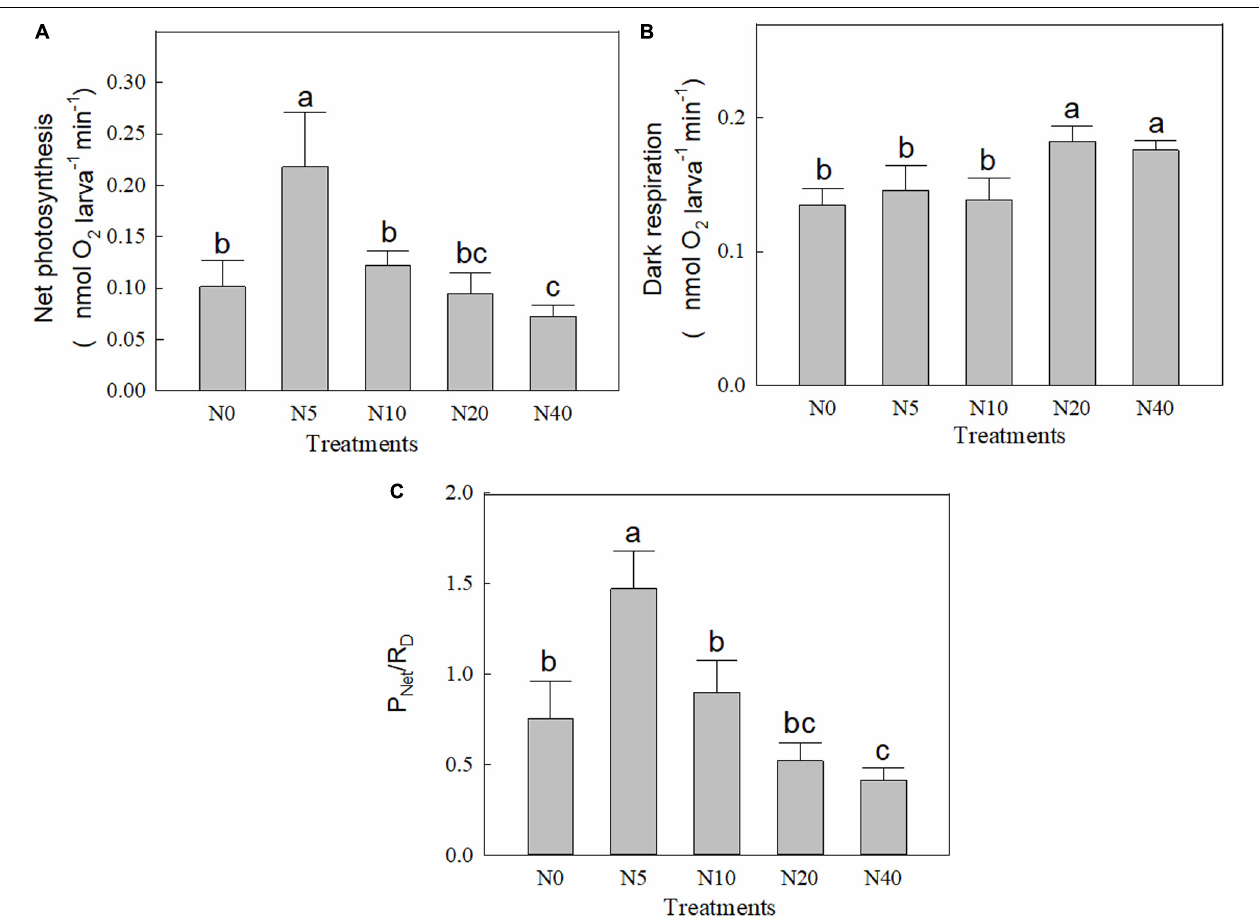
FIGURE 1 | Net photosynthesis (A) , dark respiration (B) , ratio of photosynthesis to respiration (C) of P. damicornis larvae in each